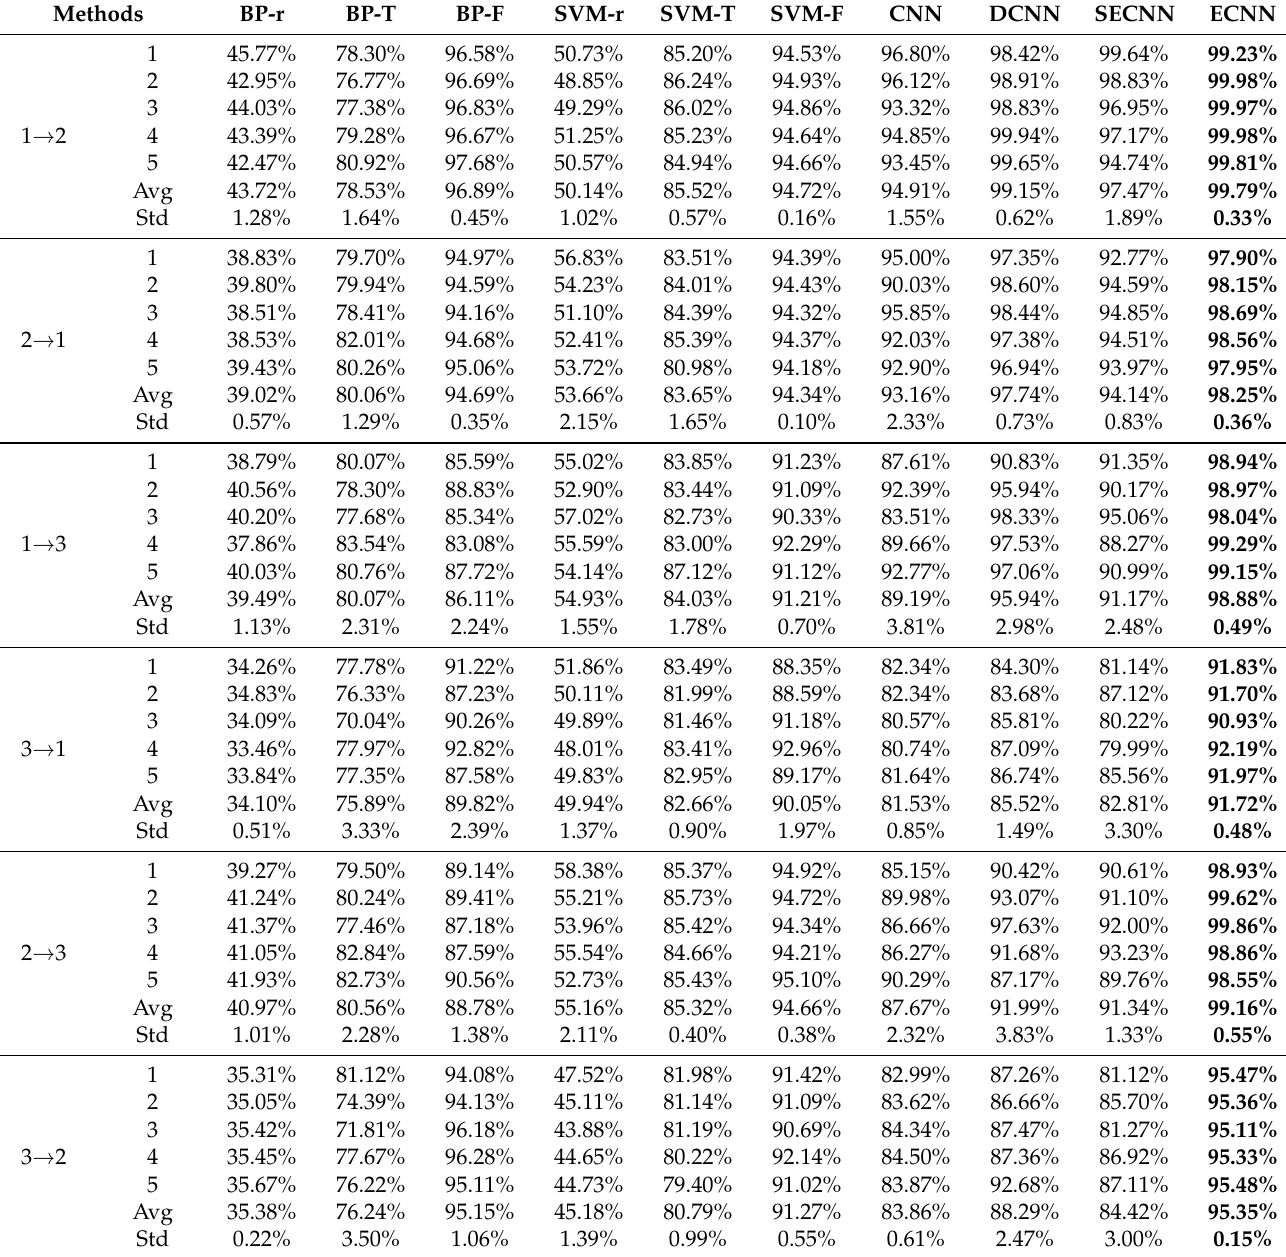
Table 6. Variable load accuracy rate of each